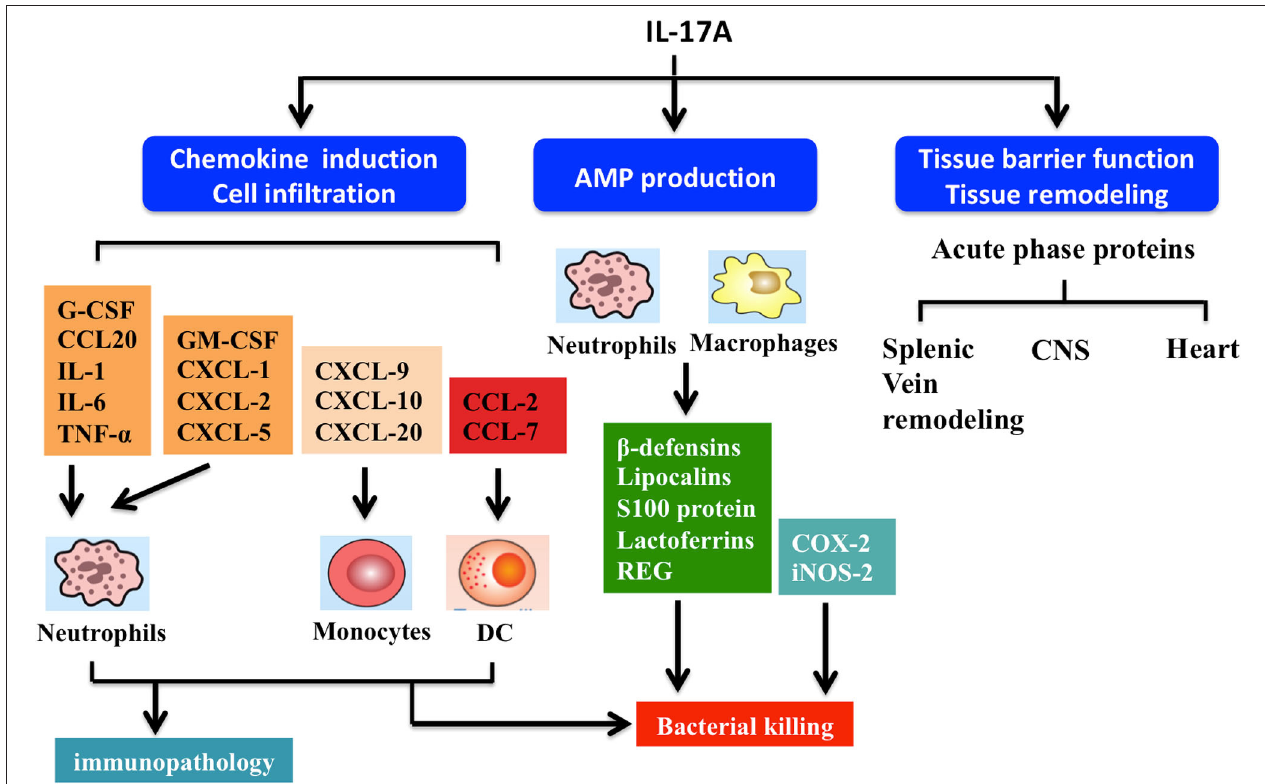
FIGURE 4 | Summary of interleukin-17A functions. IL-17A-driven signaling drives several effector functions including chemokine induction, cell infiltration, antimicrobial peptide (AMP) production, and tissue barrier function and remodeling. Firstly, IL-17A triggers production of chemokine (C-C motif) ligand (CCL)-20 and granulocyte-colony stimulating factor (G-CSF), which act in synergy with other proinflammatory cytokines (e.g., TNF- α , IL-6, and IL-1) to induce neutrophil recruitment. IL-17A regulates the release of various chemokines. For example, chemokine (C-X-C motif) ligand (CXCL)-1, CXCL-2, CXCL-5, and granulocyte-macrophage colony-stimulating factor (GM-CSF) can improve neutrophil response. CCL7, CCL2, CXCL-9, CXCL-10, and CXCL-20 modulate the activities of monocytes and dendritic cells (DCs). Secondly, IL-17A stimulate macrophages and neutrophils to produce AMPs including β -defensins, lipocalins, S100 proteins, lactoferrins,